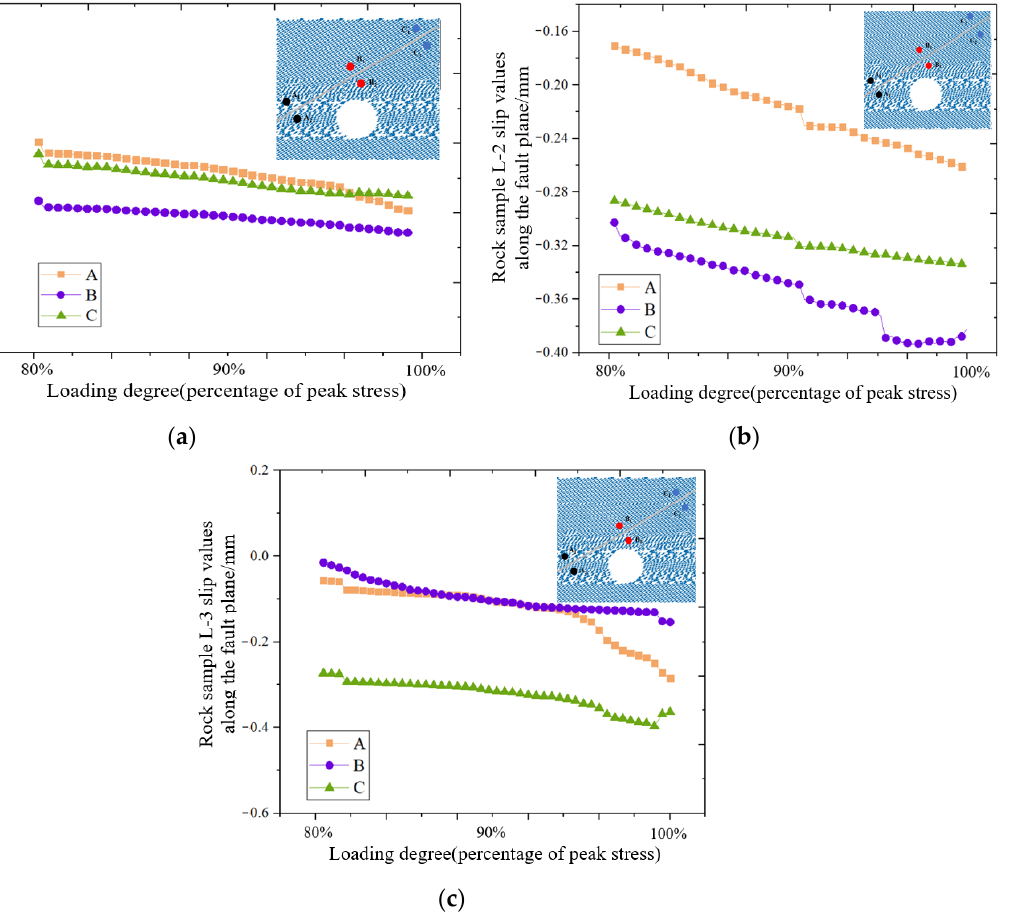
Figure 11. Schematic diagram of the relationship between fracture slip at points A, B, C, and loading degree in group L. ( a ) sample L ‐ 1 slip values; ( b ) sample L ‐ 2 slip values; ( c ) sample L ‐ 3 slip values; ( a ) sample A ‐ 45 slip values.